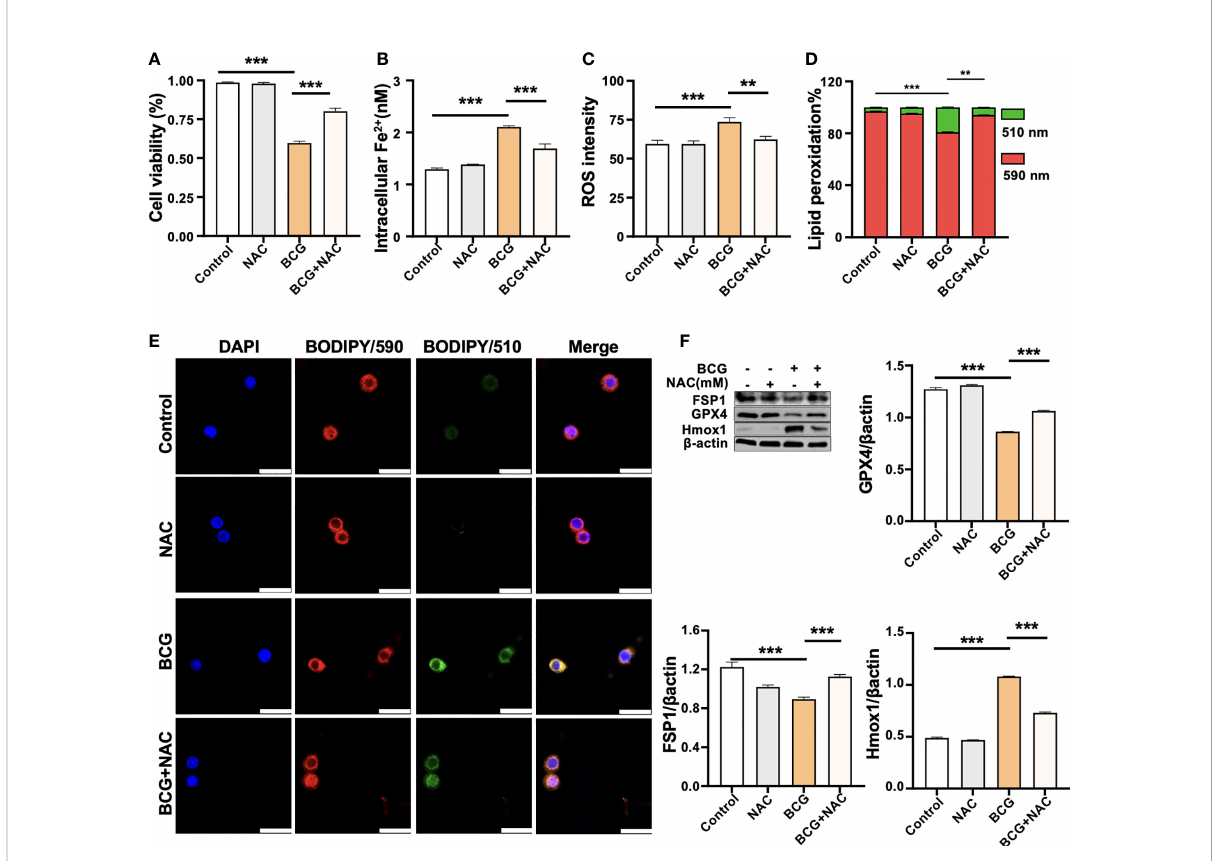
FIGURE 5 ROS scavenger NAC reduces BCG-induced macrophage ferroptosis. RAW264.7 macrophages were preincubated in medium containing 2.0 mM NAC for 1 h prior to being infected with BCG at an MOI of 5 for 24 h, before they were harvested for analysis. (A – D) The viability (A) , intracellular Fe 2+ (B) , intracellular ROS (C) , and lipid peroxidation (D) of RAW264.7 macrophages treated with the indicated conditions, as determined by Trypan Blue assay, iron ion probes, fl ow cytometry, and BODIPY 581/591 C11 assays, respectively. (E) Representative fl uorescence images of BODIPY 581/591 C11-labeled lipoxidation of polyunsaturated fatty acids in RAW264.7 macrophages of the indicated conditions showed the reduction of BCG-induced lipoxidation in cells pretreated with NAC. Cell nuclei were counterstained with DAPI. (F) Representative blots and semi-quantitative analysis of Gpx4, Fsp1, and HO-1 proteins of RAW264.7 cells treated with the indicated conditions. The NAC pretreatment increased Gpx4 and Fsp1 expression, but decreased Hmox1 protein in BCG-infected cells. Data